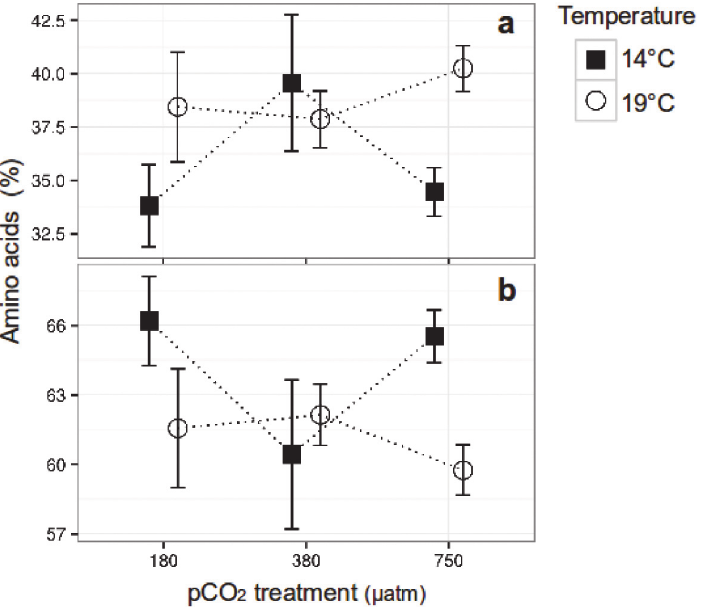
Fig 3. Relative amino acid content in Cylindrotheca fusiformis . (a) Essential [EA] and (b) Non-essential [NEA] amino acids, cultured under three CO 2 conditions and two temperatures for > 250 generations. a) EA showed a significant interaction between CO 2 and temperature. Additionally, temperature alone showed a significant difference, and although CO 2 affected its concentration, it was not significant. b) NEA showed the same effects as observed in EA. Error bars denote ± 1 standard deviation (n = 3, with exception of the 180 CO 2 -19°C treatment, where n =